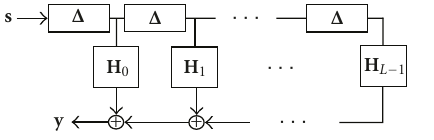
Figure 1: Frequency-selective MIMO channel